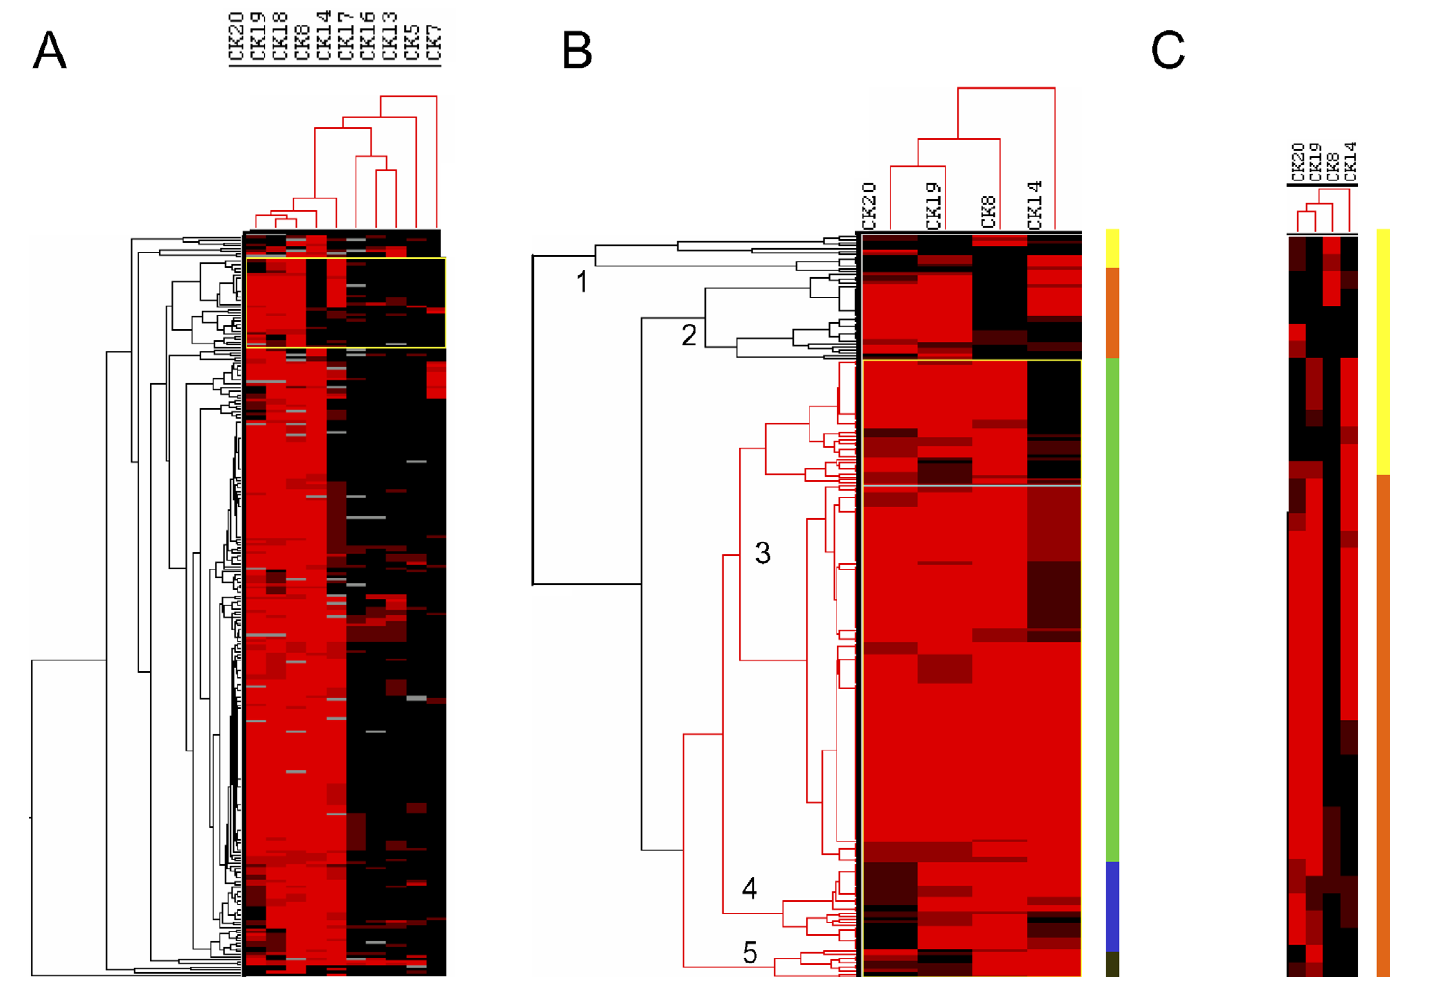
Fig. 2. (A) Hierarchical cluster analysis of colorectal carcinoma tissue microarray immunostaining results. For each of the antibodies indicated at the top of the figure, strong positive staining is indicated by a red square, moderate staining by a light brown, weak positive by dark brown, absence of staining as black, and no available data as grey. The dendogram at the top shows the clustering of antibodies based on the relatedness of tumours stained by each antibody. The dendogram on the left side shows the clustering of the tumours based on the degree of similarity of their immunohistochemical staining results. (B) Cluster analysis with cytokeratin 20, 19, 8 and 14. (C) Enlarged portion from Cluster 1 (yellow), the so called “extreme shorter survival cluster” with reduced CK20 and CK8 staining (see vertical line) and cluster 2 (orange), together the “shorter survival cluster” with prominently reduced CK8 staining (see vertical line). Number and different colors: cluster group 1 (yellow), 2 (orange), 3 (green), 4 (blue), 5